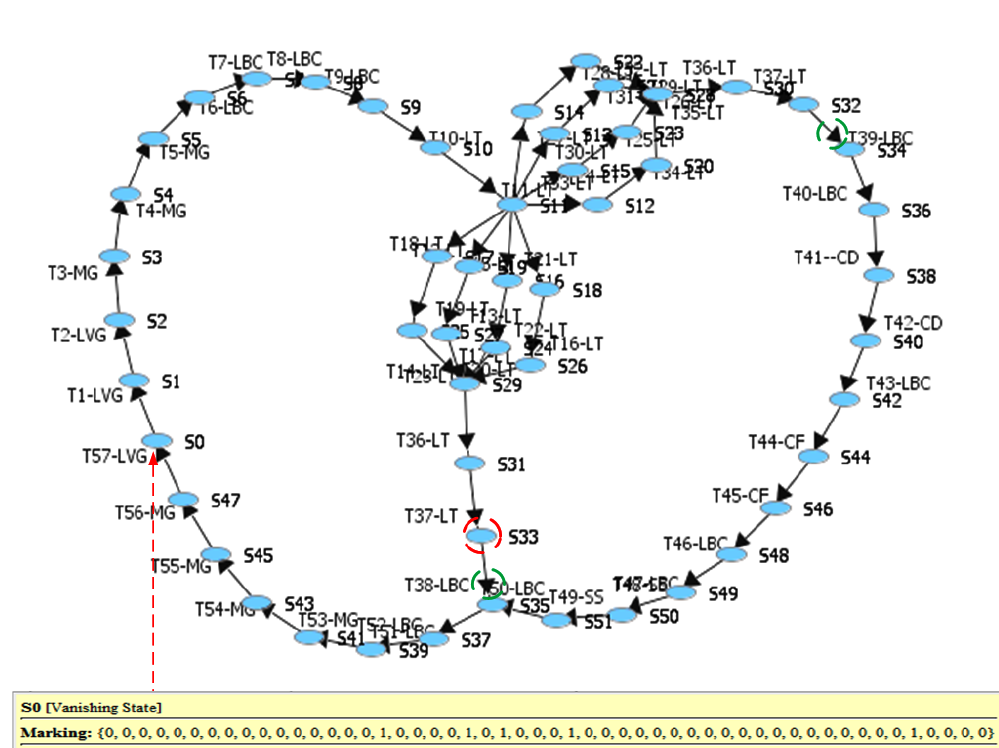
Figure 8. HPN Reachability